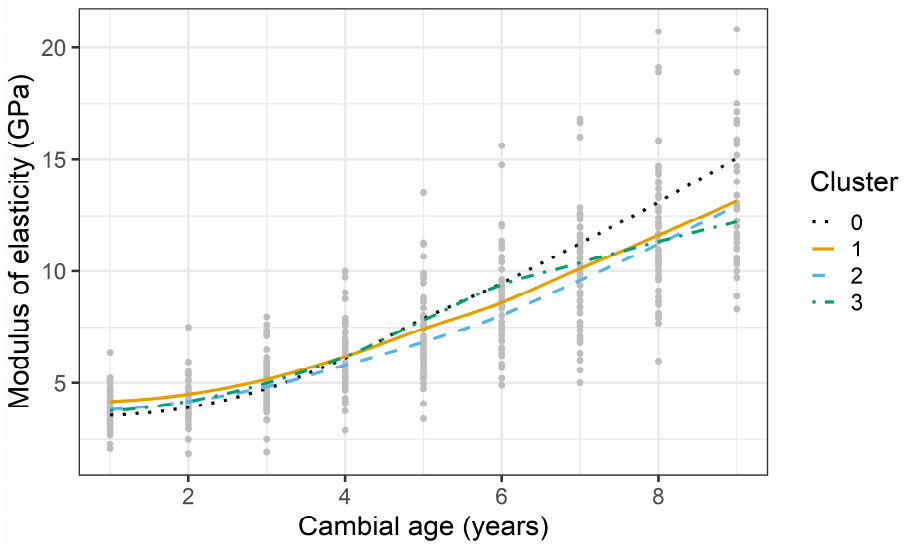
Figure 7. Stiffness radial variation for trees representing the average wood property values of each cluster. Antony et al. [41] reported stiffness values for the same regions examined by Jordan et al. [35]. Corewood stiffness values for static bending samples from a height of 2.4 m ranged from 3.6 GPa (North Atlantic coastal plain) to 5.6 GPa (gulf coastal plain), while outerwood stiffness ranged from 8 GPa (North Atlantic coastal plain) to 10.9 GPa (gulf coastal plain). The stiffness averages for the